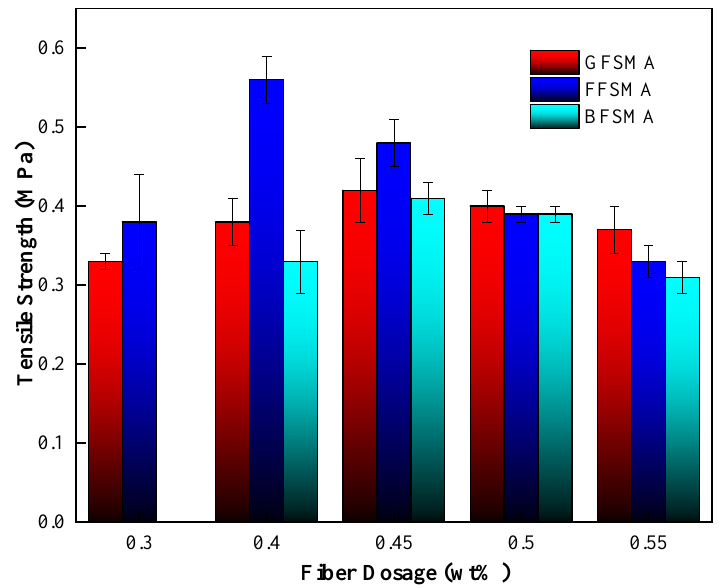
Figure 5. Tensile strength of mixtures.